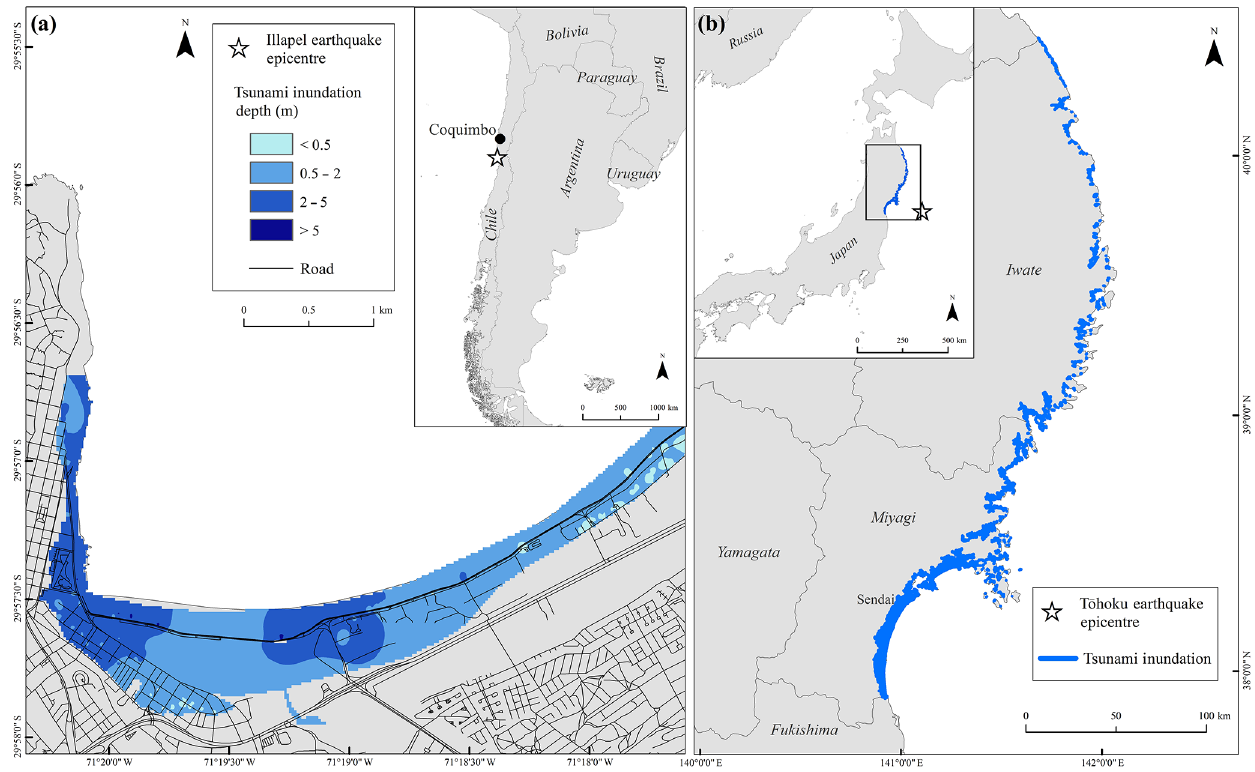
Figure 1. Tsunami inundation in Coquimbo for the 2015 Illapel tsunami, Chile (a) , and in Miyagi and Iwate prefectures for the 2011 T¯ohoku tsunami, Japan (b) . © OpenStreetMap contributors 2015. Distributed under a Creative Commons BY-SA